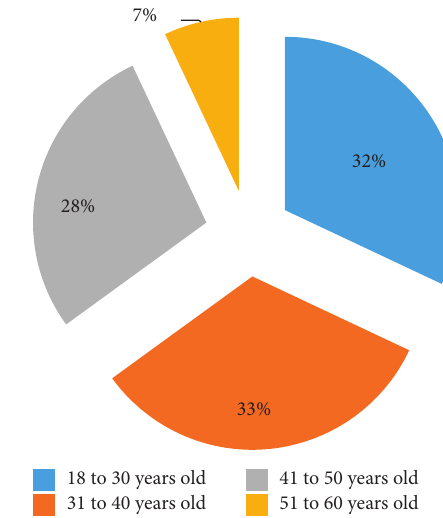
Figure 1: Age distribution of the drivers in traffic accident